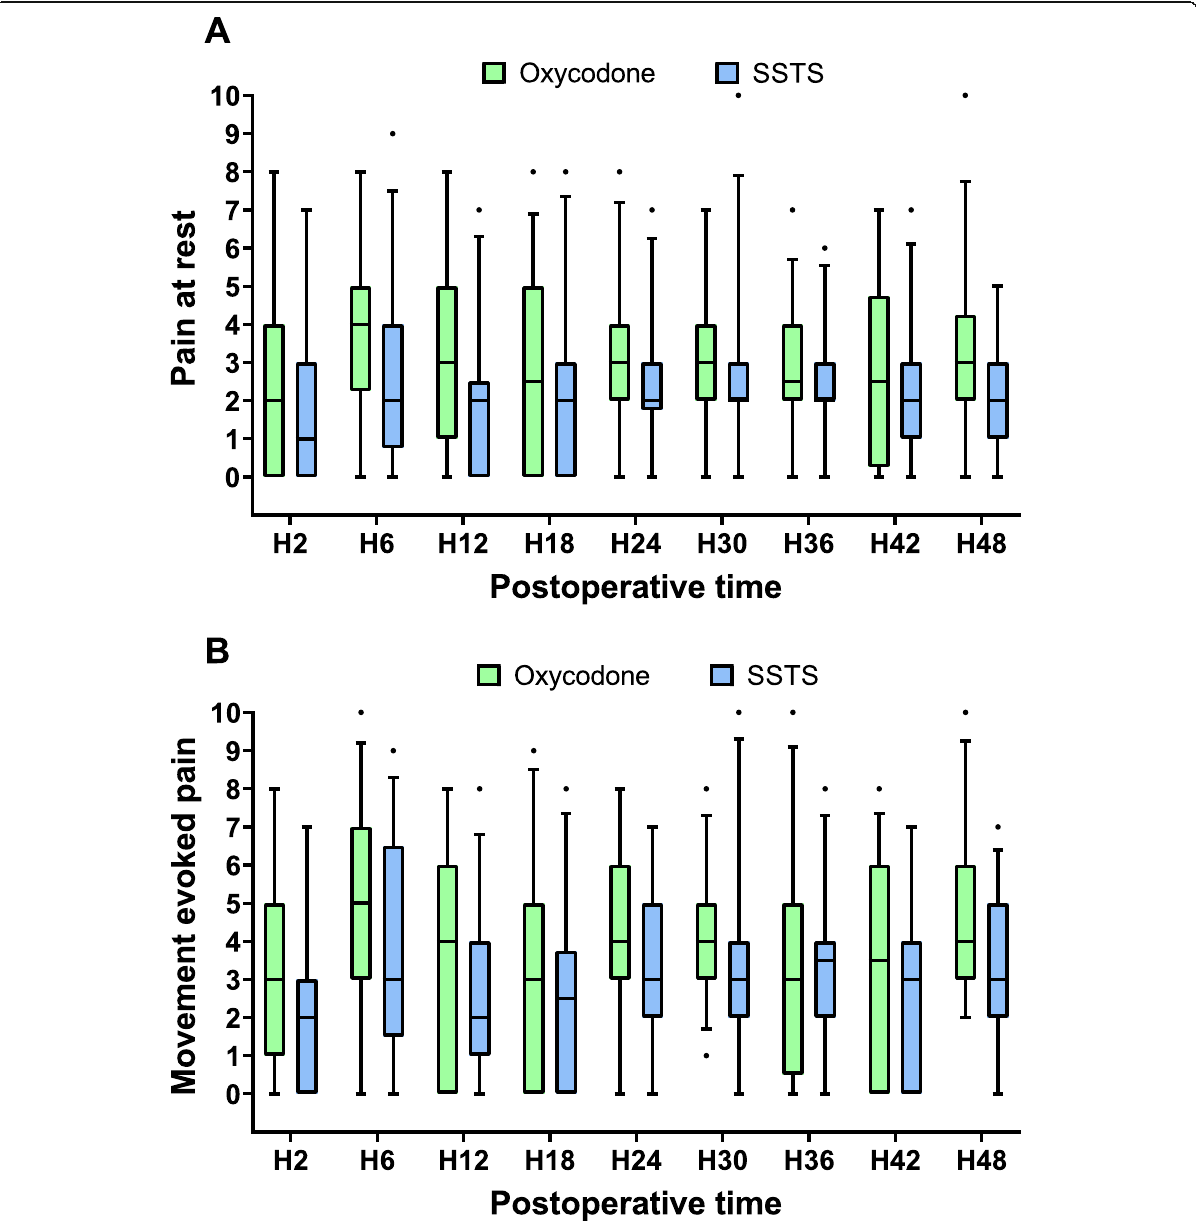
Fig. 3 Box and whisker plots of postoperative pain scores over 48 h. a . Pain score at rest. b . Dynamic pain score. Solid horizontal lines represent the median, boxes indicate interquartile range (Q25-Q75), whiskers represent 5th percentile and 95th percentile and dots are the extreme values. No statistical difference was found. SSTS = sufentanil sublingual tablet